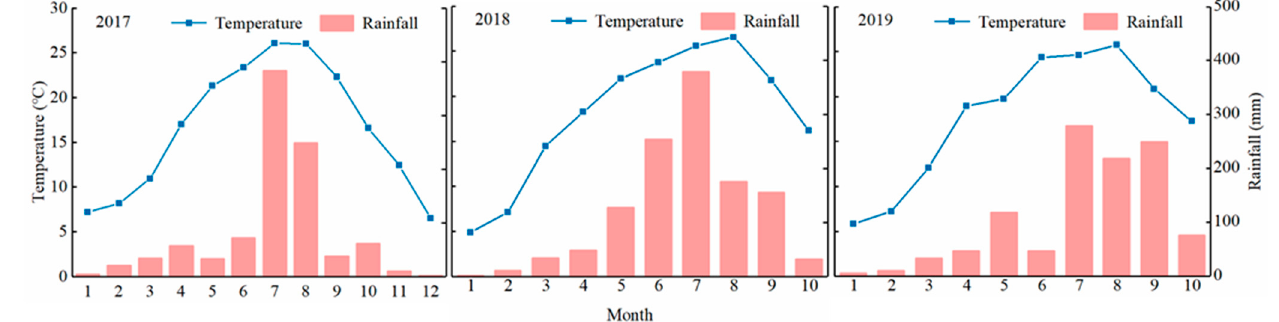
Figure 1. Meteorological data of the experimental area, including temperature and rain full in 2017–2019.